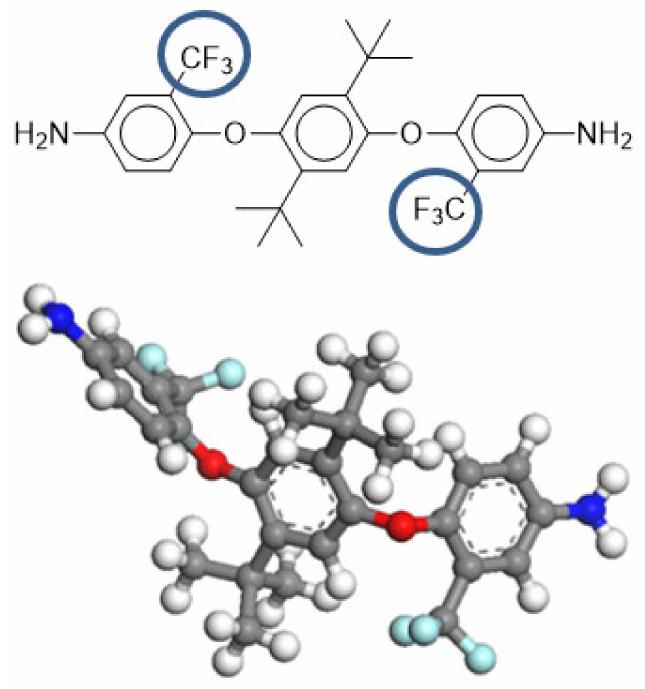
Figure 2. Structure of 4-bis(4-amino-2-trifluoromethylphenoxy)2,5-di- tert -butylbencene (CF 3 TBAPB).